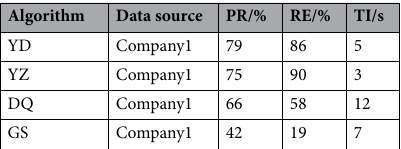
Table 1. Accuracy comparison among four